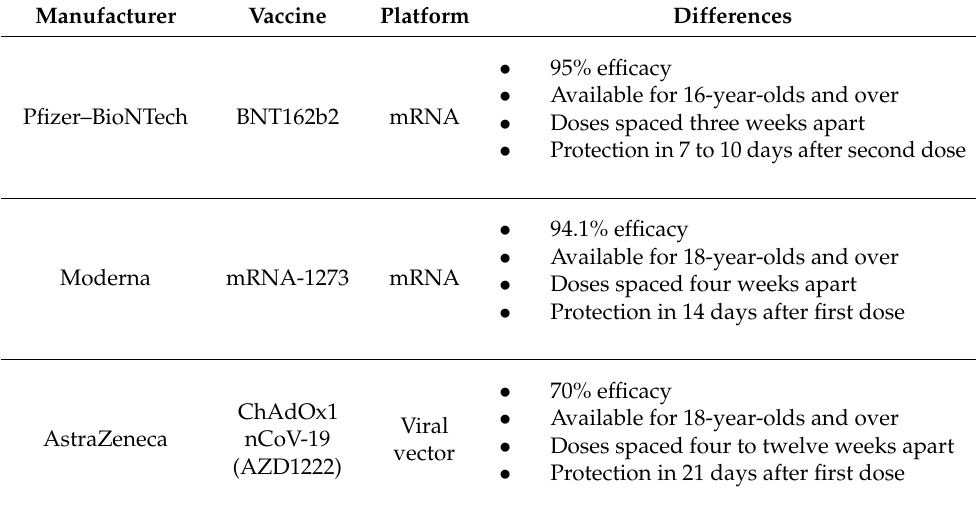
Table 2. The differences between the vaccines currently in